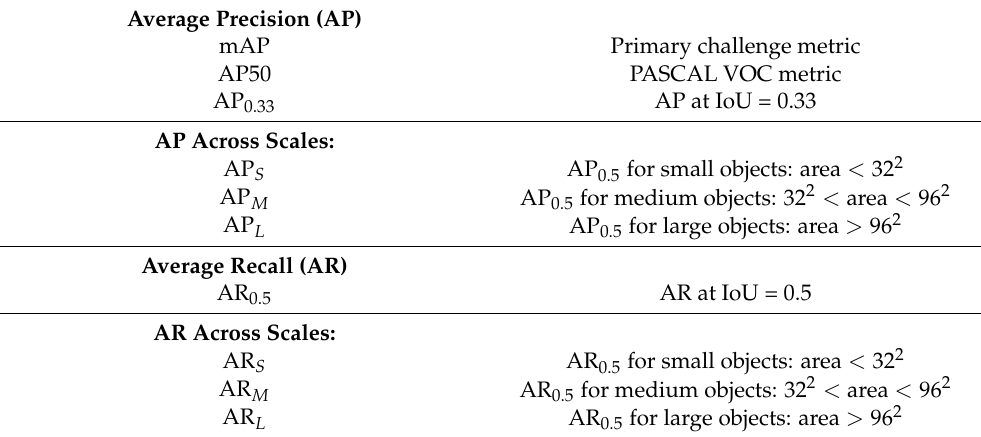
Table 5. COCO evaluation